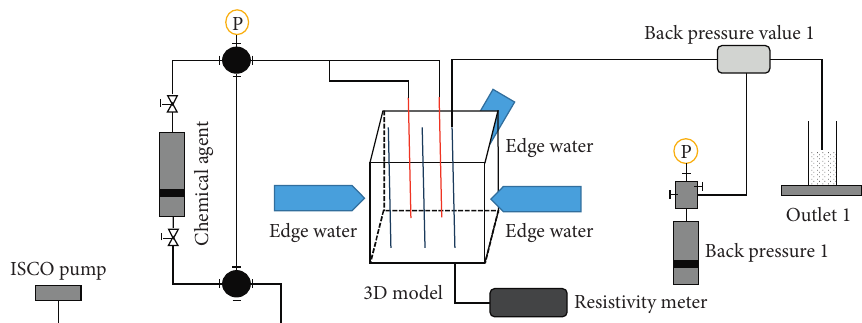
Figure 1: Experimental procedure of a high-temperature, high-pressure 3D reservoir simulation system.